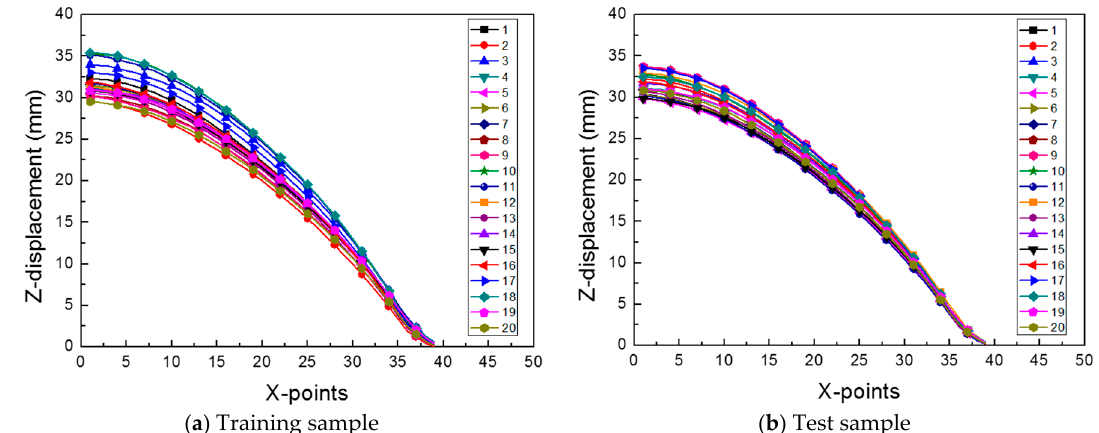
Figure 9. The z-displacement of the sheet metal for ( a ) 20 training samples and ( b ) 20 test samples.